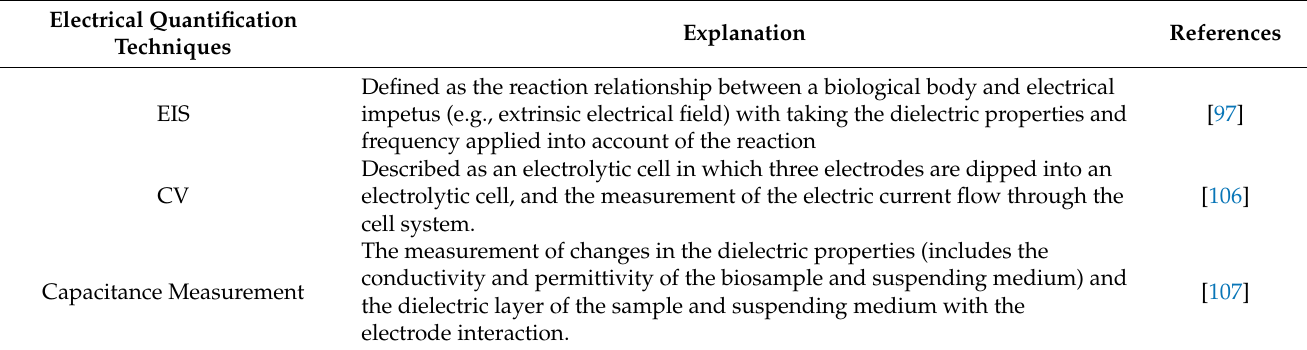
Table 6. Electrical quantification techniques concept of principles and further explanation.